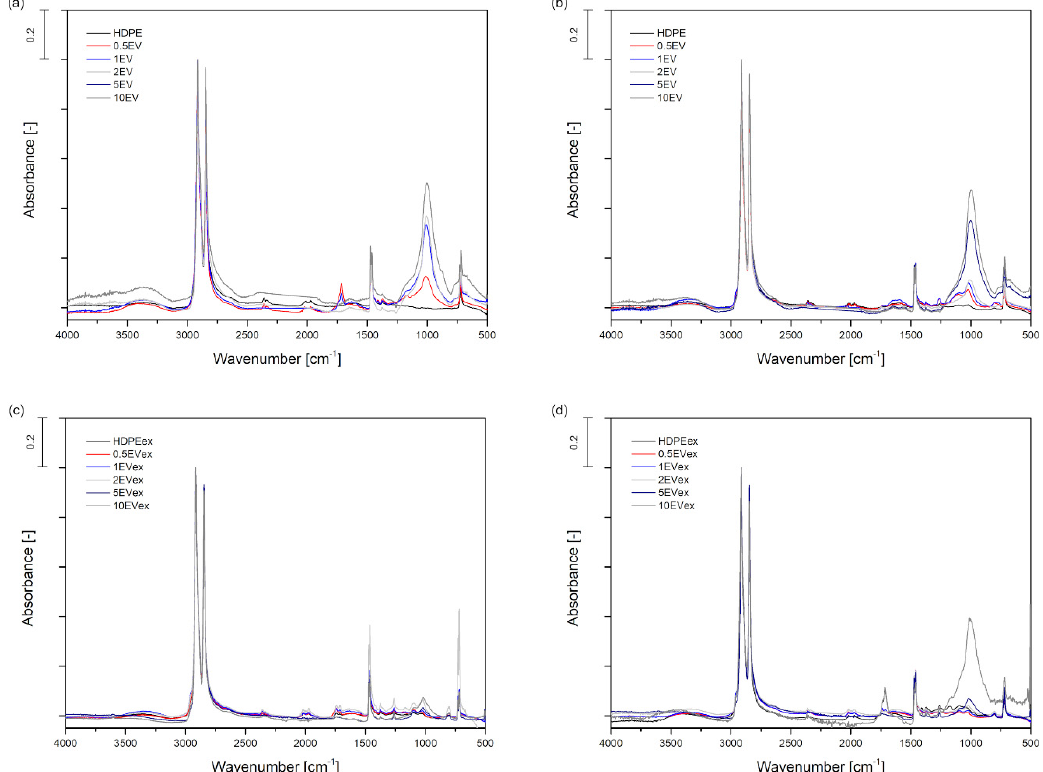
Figure 2. FTIR spectrums of HDPE composites with expanded vermiculite: dry blended measured from outer ( a ) and inner side ( b ); melt compounded measured from outer ( c ) and inner side ( d ).